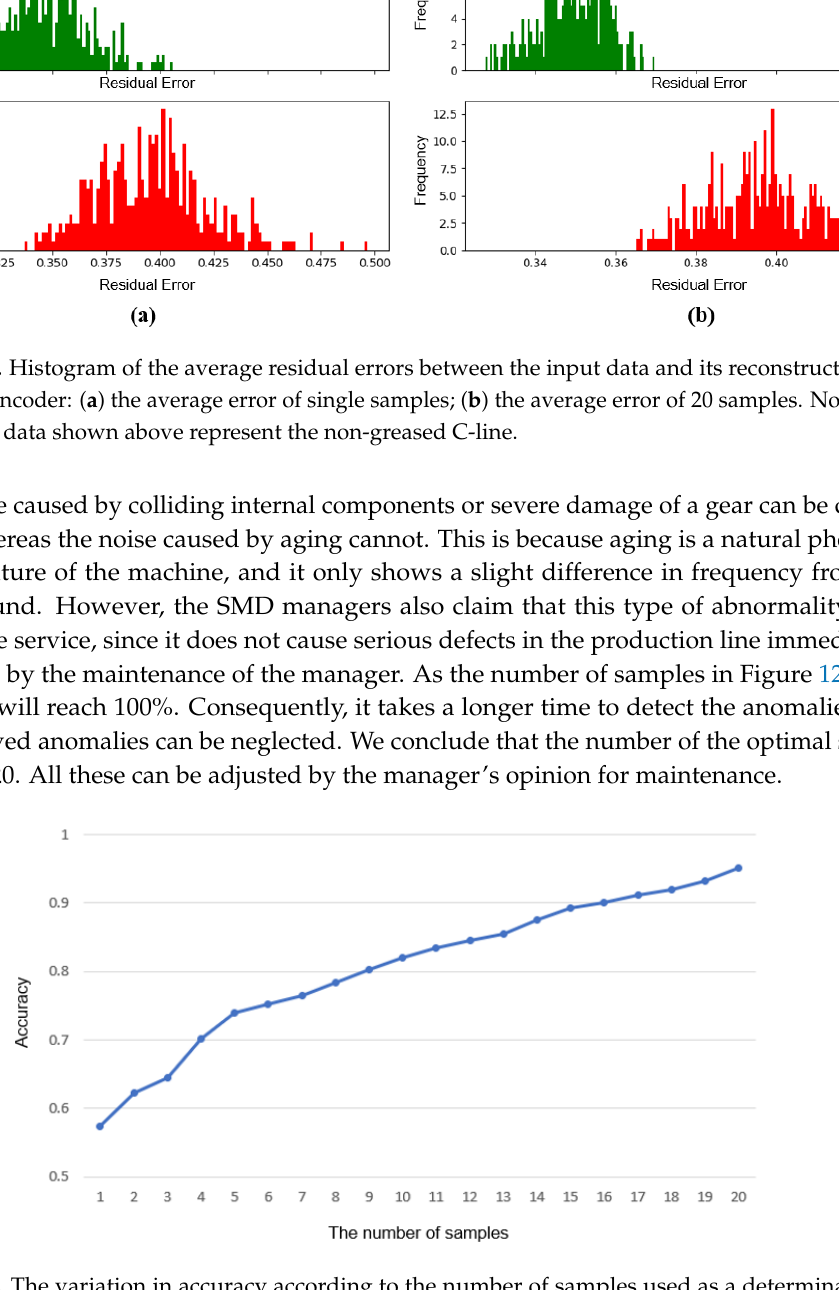
Figure 12. The variation in accuracy according to the number of samples used as a determinant for a normal C-line. The entire audio data recorded in the abnormal line contain the features independent of being abnormal and normal, such as the rest